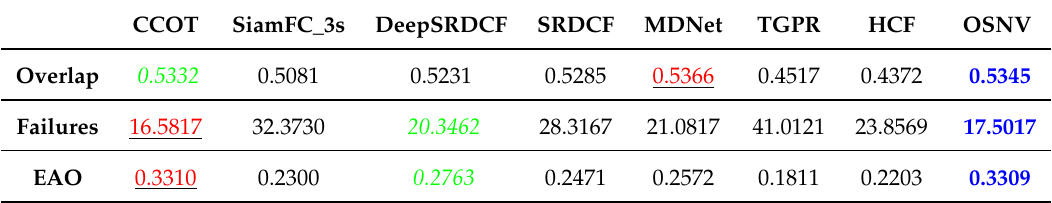
Table 1. The baseline results in VOT-2016. The red fonts with under line, blue bold fonts and green italic fonts indicate the best, the second best and the third best performance. The EAO means expected average overlap, best viewed in color.